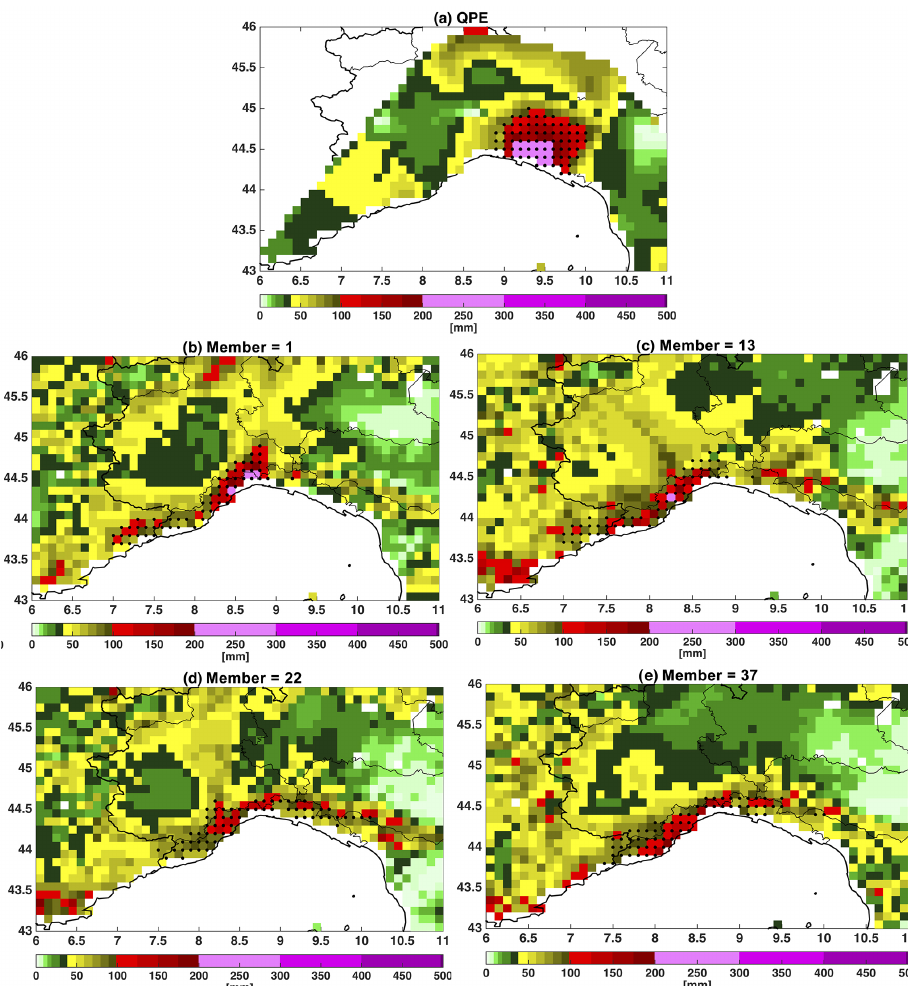
Figure 14. QPE regridded at 10km grid spacing (a) and QPF from members 1 (b) , 13 (c) , 22 (d) and 37 (e) , regridded at 10km grid spacing (lower panels). Dots identify the areas of paired